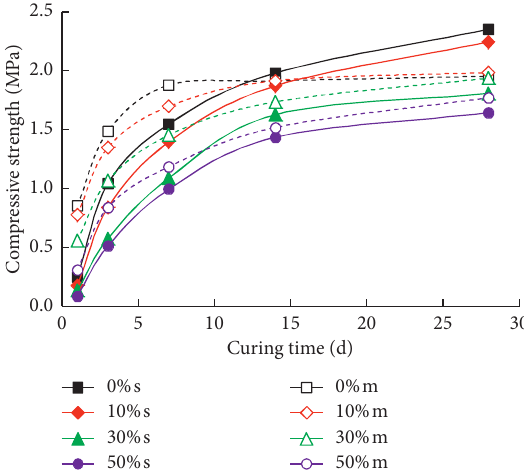
Figure 12: Relationship between compressive strength and curing time (containing fly ash). Note: 0% s denotes the value of the test when the fly ash content is 0% under standard curing conditions. 0% s denotes the value of the test when the fly ash content is 0% under temperature matched curing